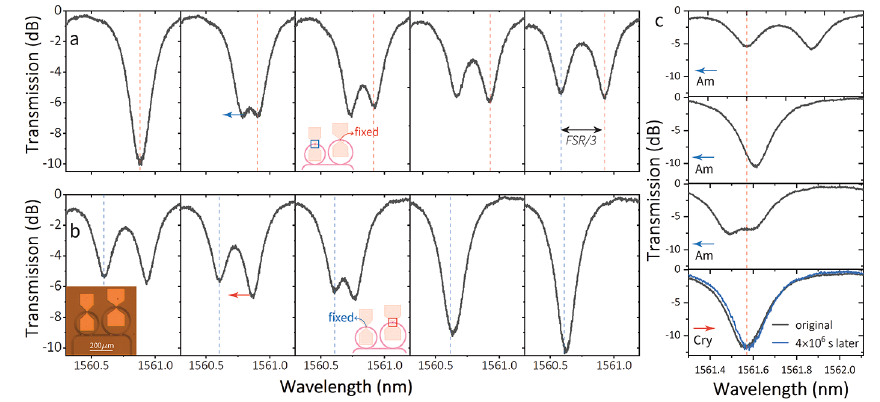
Fig. 6 Optical trimming of micro-ring resonators. a Detuning of two initially superimposed resonance dips cor- responding to two micro-ring resonators with 100 μm (blue line) and 120 μm (red line) in radius connected to a common bus waveguide. The largest ring is left fixed while the smaller ring is phase-shifted via step amorphiza- tion to fully isolate the response of each ring. b Trimming of the 120 μm micro-ring to match the resonance dip of the smaller ring (fixed), thus, correcting the detuning in a but with an overall wavelength shift of 0.6 nm. The inset shows an optical microscope image of the actual device. c Demonstration of combined amorphization and crystallization to properly trim one micro-ring resonator and compensate ‘over-shifting’. Nonvolatile response is demonstrated in the last state of the device (bottom panel) which was measured 4 × 10 6 s (i.e. 47 days)